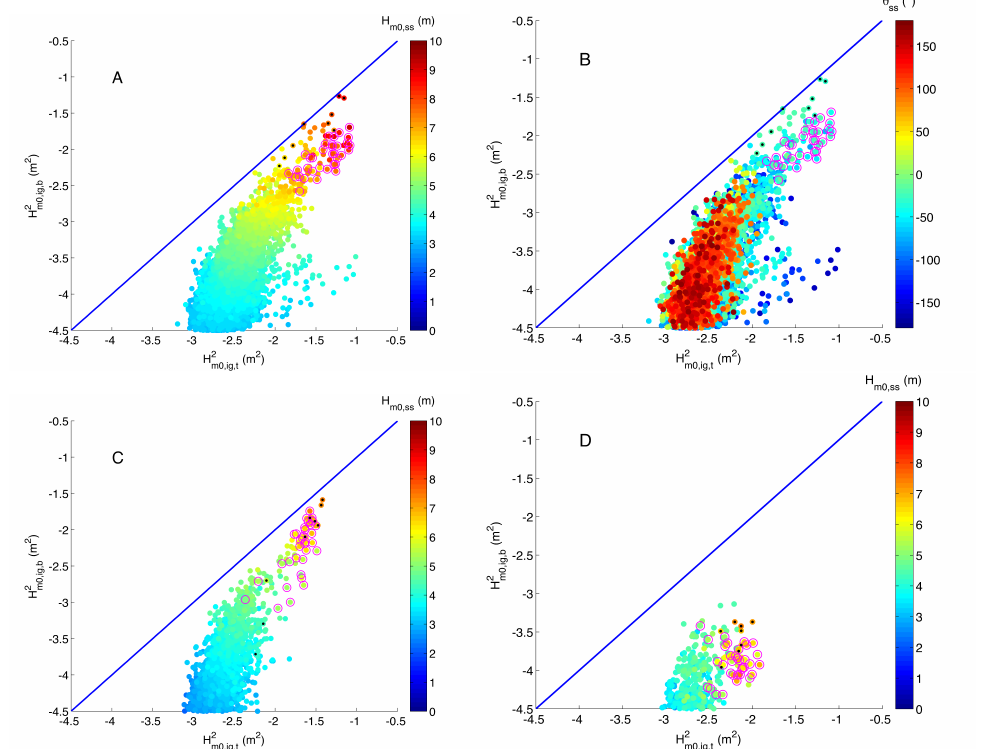
Figure 2. Hourly observations of total infragravity (IG) variance ( H 2 ) versus predicted bound IG m 0, ig , t variance ( H 2 ) for storm conditions ( H m 0, ss > 3 m) at station A12 from 2010–2018. The colors in m 0, ig , b the panels ( A , C , D ) show the sea-swell wave height ( H m 0, ss ) at A12, Q1 and EUR, respectively (color bar in m). The colors in panel ( B ) correspond to the mean sea-swell wave direction ( θ ss ) at A12 (color bar in nautical degrees, the direction where waves come from measured clockwise from geographic north). Open circles highlight conditions corresponding to the peak of storm Xaver and black dots to storm Egon, respectively. Results are presented at a log10 scale where − 1 corresponds to 10 − 1